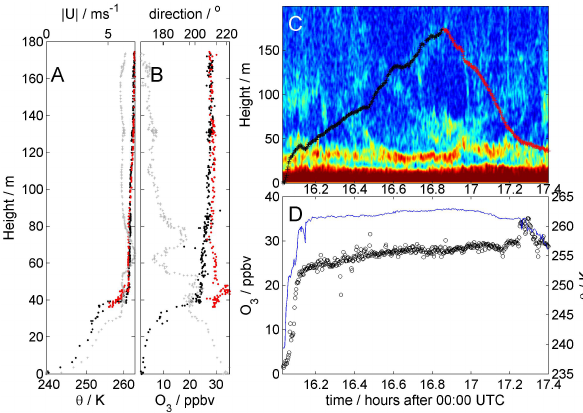
Fig. 3. Tethersonde profiling experiment of 21 August 2007. (A) profile of potential temperature ( θ) (black = ascending flight; red = descending) with wind speed during ascending flight shown in grey; (B) profile of ozone (black = ascending flight; red = descend- ing) with wind direction during ascending flight shown in grey; (C) sodar trace which shows, using a false-colour scale, how structure within the atmosphere develops with time – the flight path of the blimp is shown by the black and red lines; (D) measurements of ozone (circles) and potential temperature (blue line) plotted against time. By comparing (C) and (D) it is possible to see at what altitude, and in which air mass, measurements of ozone and θ were